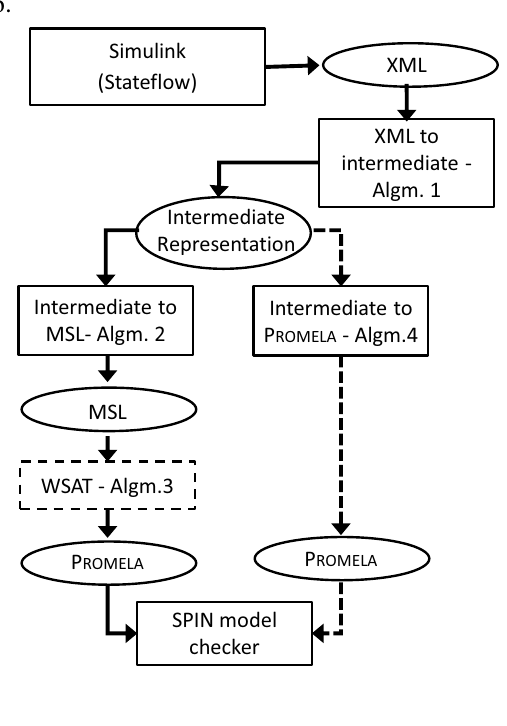
Fig. 1. Tool chains considered in this